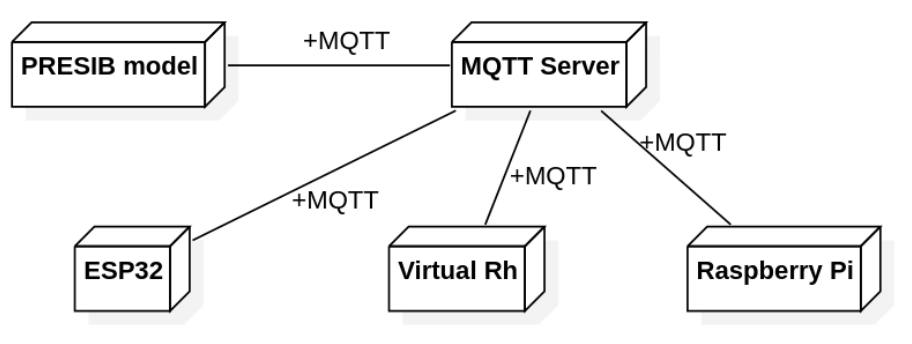
Figure 6. Deployment